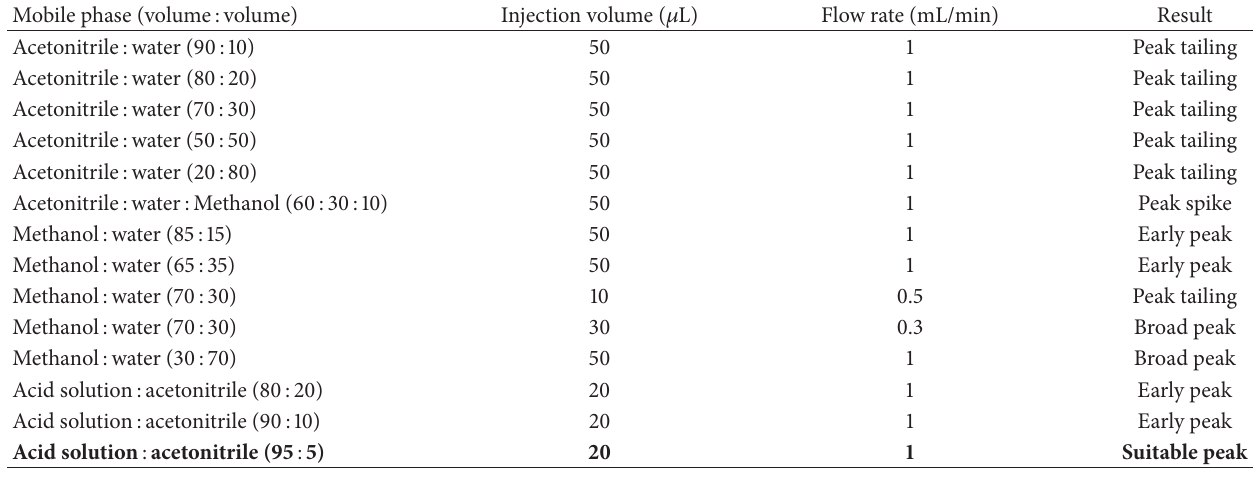
Table 1: Variation in analytical method conditions. OXPt samples (15.0 𝜇 g/mL) were analyzed in HPLC equipment using a C 18 column, with UV detection fixed at 255 nm, at 25 ∘ C.